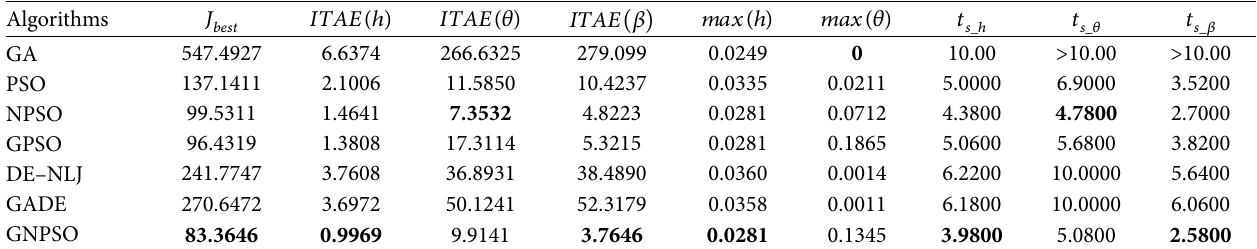
Table 6: Comparison of the control performance obtained by GA, PSO, NPSO, GPSO, DE–NLJ, GADE and GNPSO for linear wing vibration